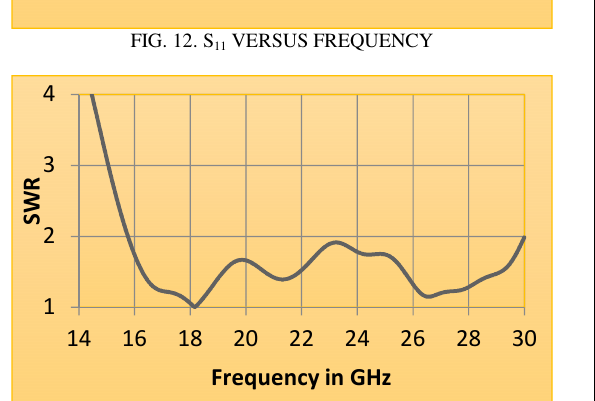
FIG 16: REFLECTION COEFFICIENT VERSUS FREQUENCY OF THE FABRICATED ANTENNA